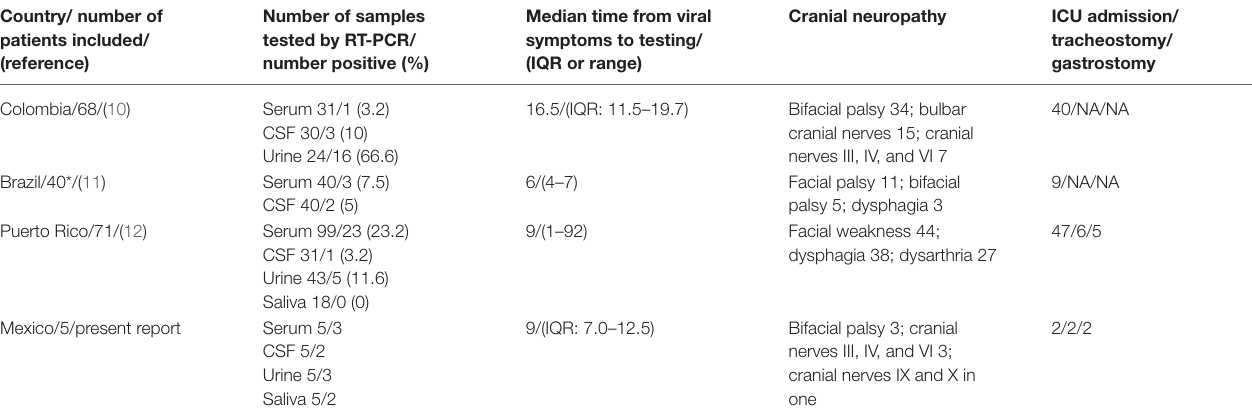
TABLE 2 | Comparison of data from Latin American and Puerto Rico studies of GBS associated with Zika virus infection. Country/ number of patients